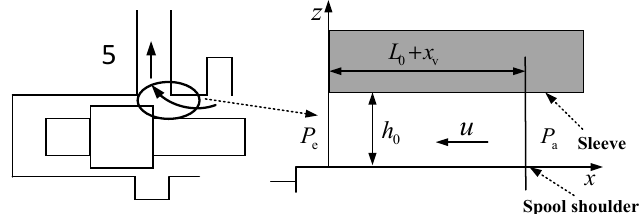
Figure 8. Schematic of valve core clearance flow.